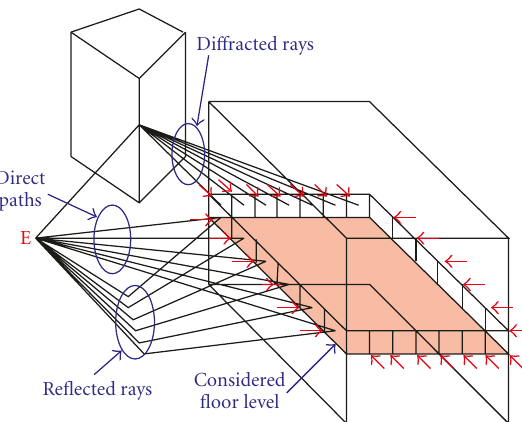
Figure 1: Schematic representation of the combined approach. First the outdoor part is simulated, then the incoming indoor flows are computed and used for the indoor